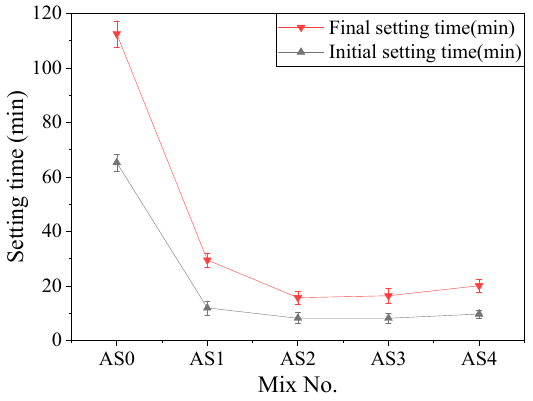
Figure 1. E ff ect of aluminum sulfate on the setting time. Figure 1. Effect of aluminum sulfate on the setting time. Figure 1. Effect of aluminum sulfate on the setting time.